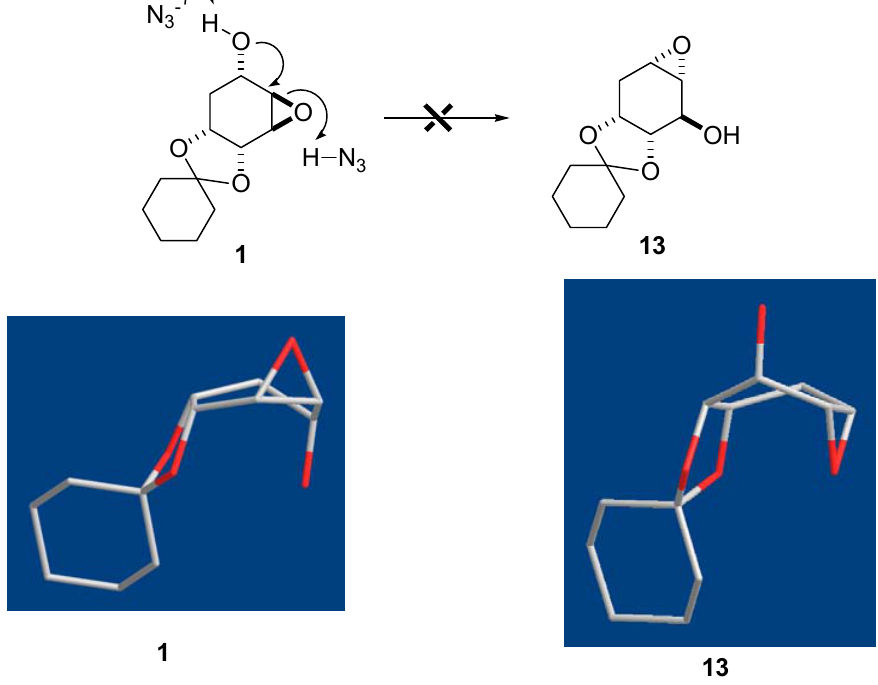
Figure 5. Three-dimensional representations of structures 1 and 13